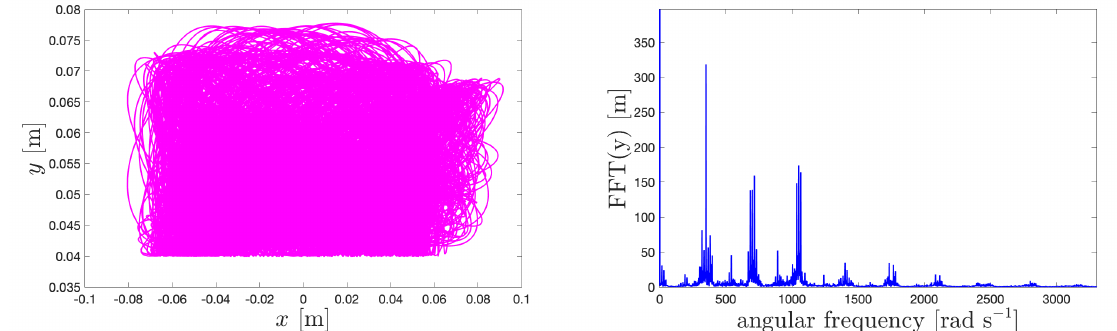
Figure 10. Investigatedsystem’s (1) time histories of x , y , and ϕ for e T = 0.015 m, ω = 2.2 rad s − 1 , and z a = 0.0028 m.